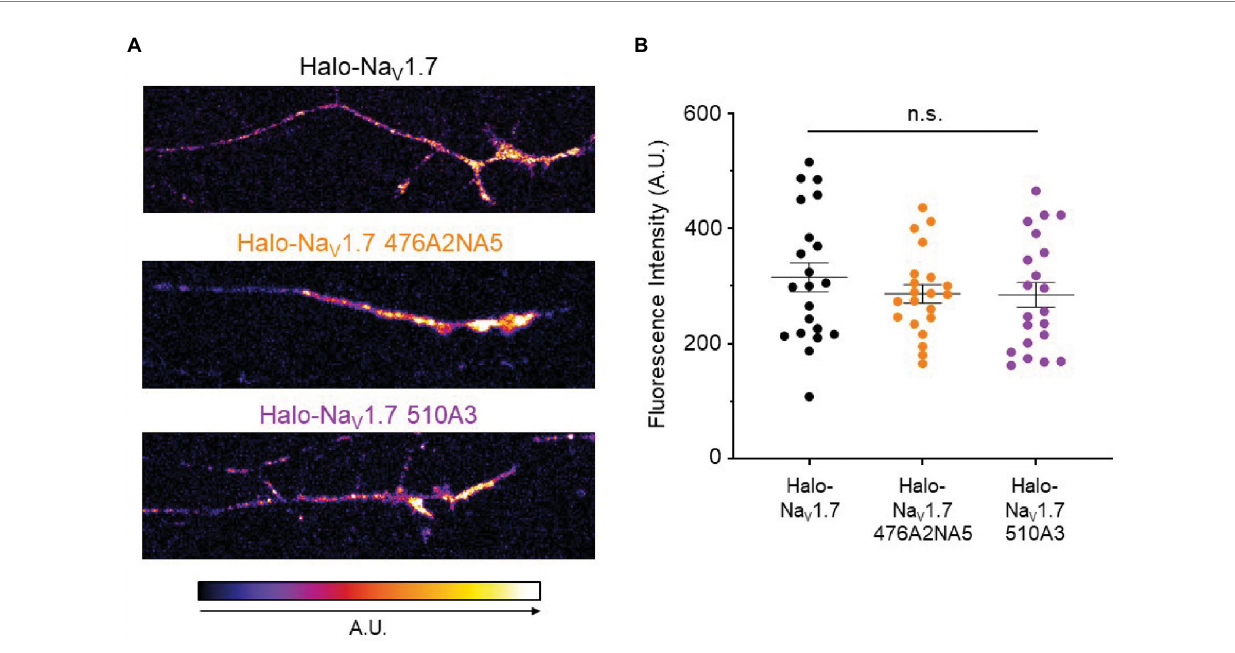
FIGURE 4 Mutations of the polybasic motifs in the Na V 1.7 L1 do not affect accumulation of the channel at the axonal terminal. (A) DRG neurons transfected with either Halo-Na V 1.7, Halo-Na V 1.7 476A2NA5, or Halo-Na V 1.7 510A3 were labeled with a cell-impermeable Halo dye after 6 days in culture. Fluorescent signal was quantified in ImageJ and mapped to the look-up table shown at the bottom of the left panel (B). There was no significant difference in fluorescent signal from Na V 1.7 at the distal axonal surface between DRG neurons transfected with either Halo-Na V 1.7 ( n = 21, from 3 cultures), Halo- Na V 1.7 476A2NA5 ( n = 21, from 3 cultures), or Halo-Na V 1.7 510A3 ( n = 21, from 3 cultures). Bars indicate mean ± SEM. ”ns” stands for non-significant ( p